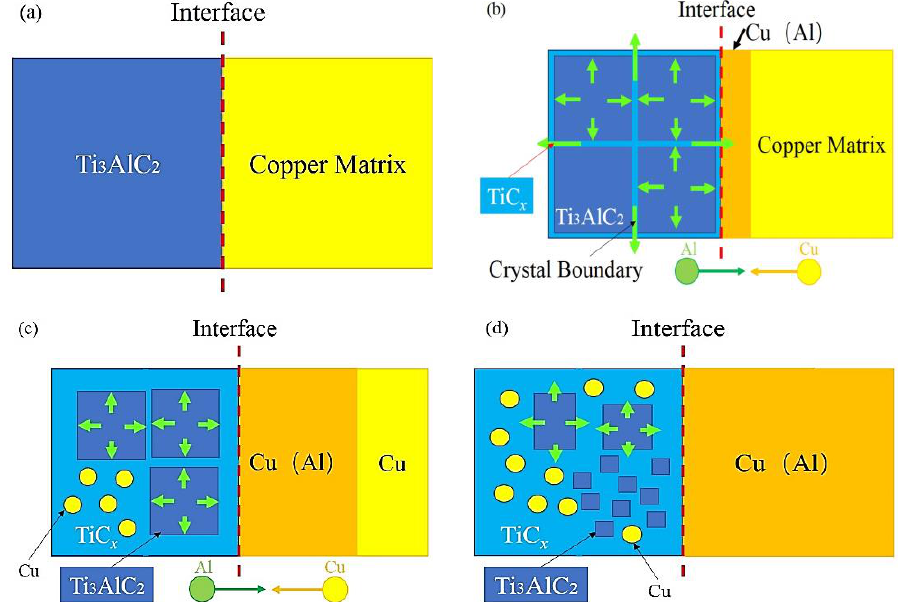
Figure 8. Model of the decomposition mechanism of Ti 3 AlC 2 : ( a ) the first stage: before sintering; ( b ) the second stage: at the beginning of diffusion; ( c ) the third stage: massive lattice diffusion; ( d ) the fourth stage: continuous decomposition of Ti 3 AlC 2 .